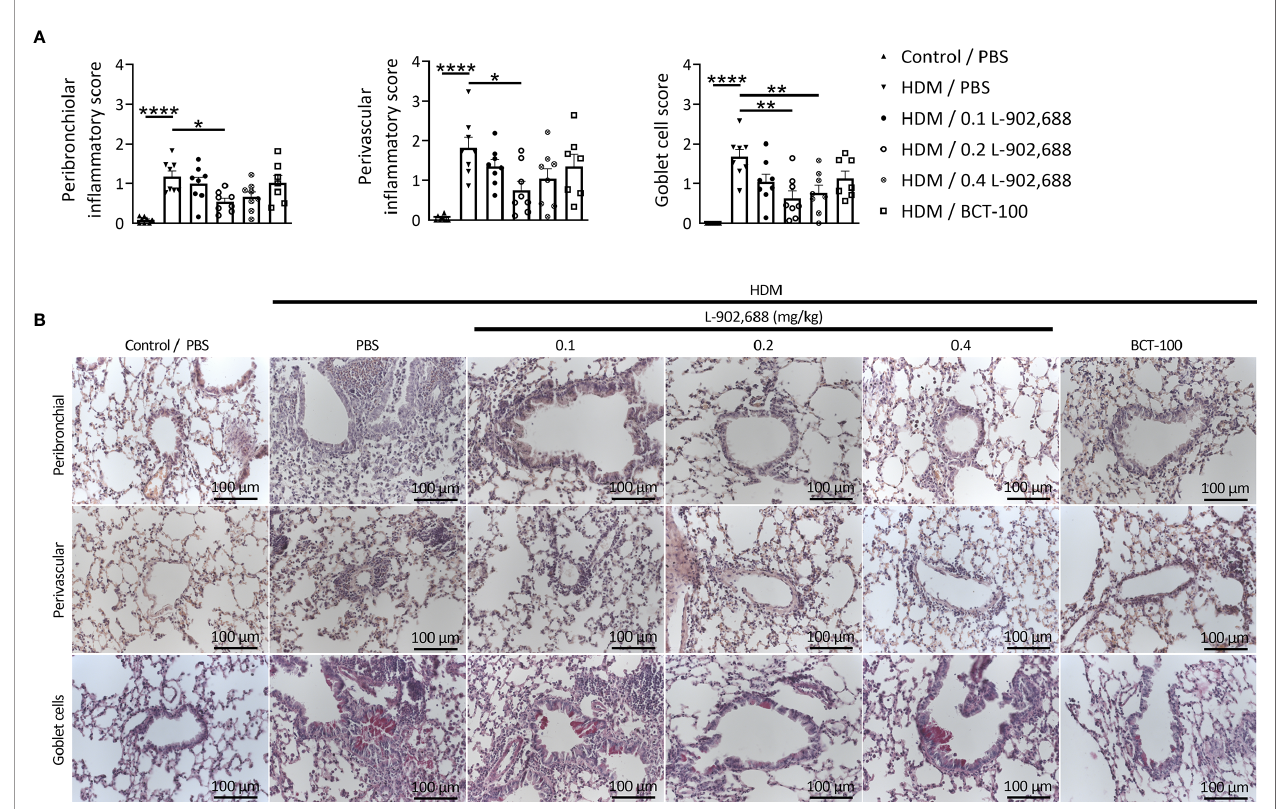
FIGURE 7 | The effect of EP4 agonist L-902,688 and arginase-1 therapy on lung in fl ammatory features in a murine model of asthma. 6- to 8-week-old female BALB/c mice were exposed to HDM or PBS on days 0, 7, 8, 9, 10 and 11. On day 7, 9 and 11 of the HDM model, mice were intravenously administered the EP4 agonist L-902,688 (0.1; 0.2 or 0.4 mg/kg), BCT-100 (20 mg/kg) or PBS. Three days after the last HDM exposure the lungs were collected and used to assess lung in fl ammatory features. (A, B) Peribronchial and perivascular in fl ammatory scores were assessed by H&E staining and goblet cell score by PAS staining of lung sections. (B) Representative microscopic pictures are shown (40x magni fi cation). Data was obtained from 7-8 independent experiments. Results of individual experiments and mean ± SEM are shown. Statistical analysis was performed with one-way ANOVA followed by Tukey ’ s multiple comparisons test. * p < 0.05, ** p < 0.01, **** p <